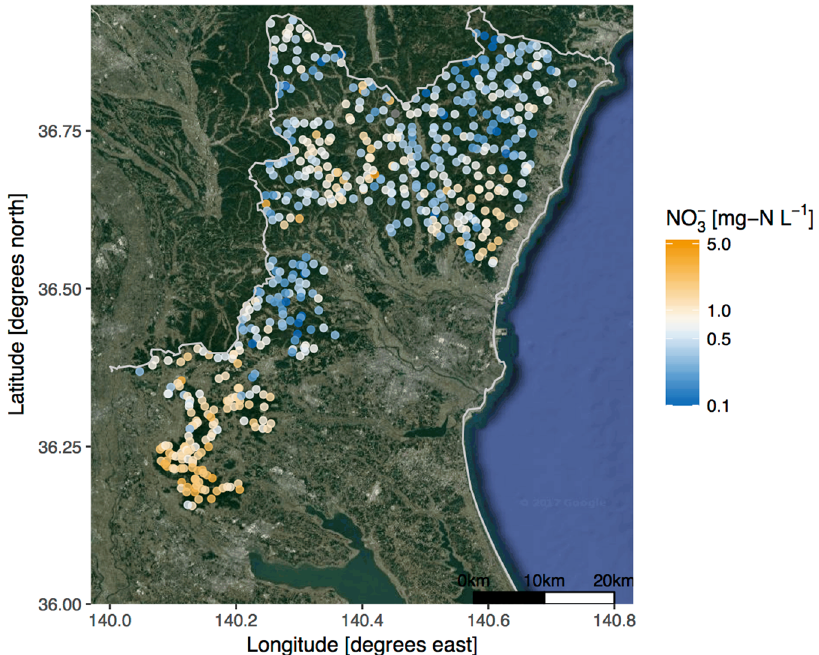
Figure 2. − NO concentrations of forest watersheds in Ibaraki. Background was obtained from ©2016 Google 3 Imagery and ©2016 TerraMetrics. Map was drawn by ggmap package 63 via Google